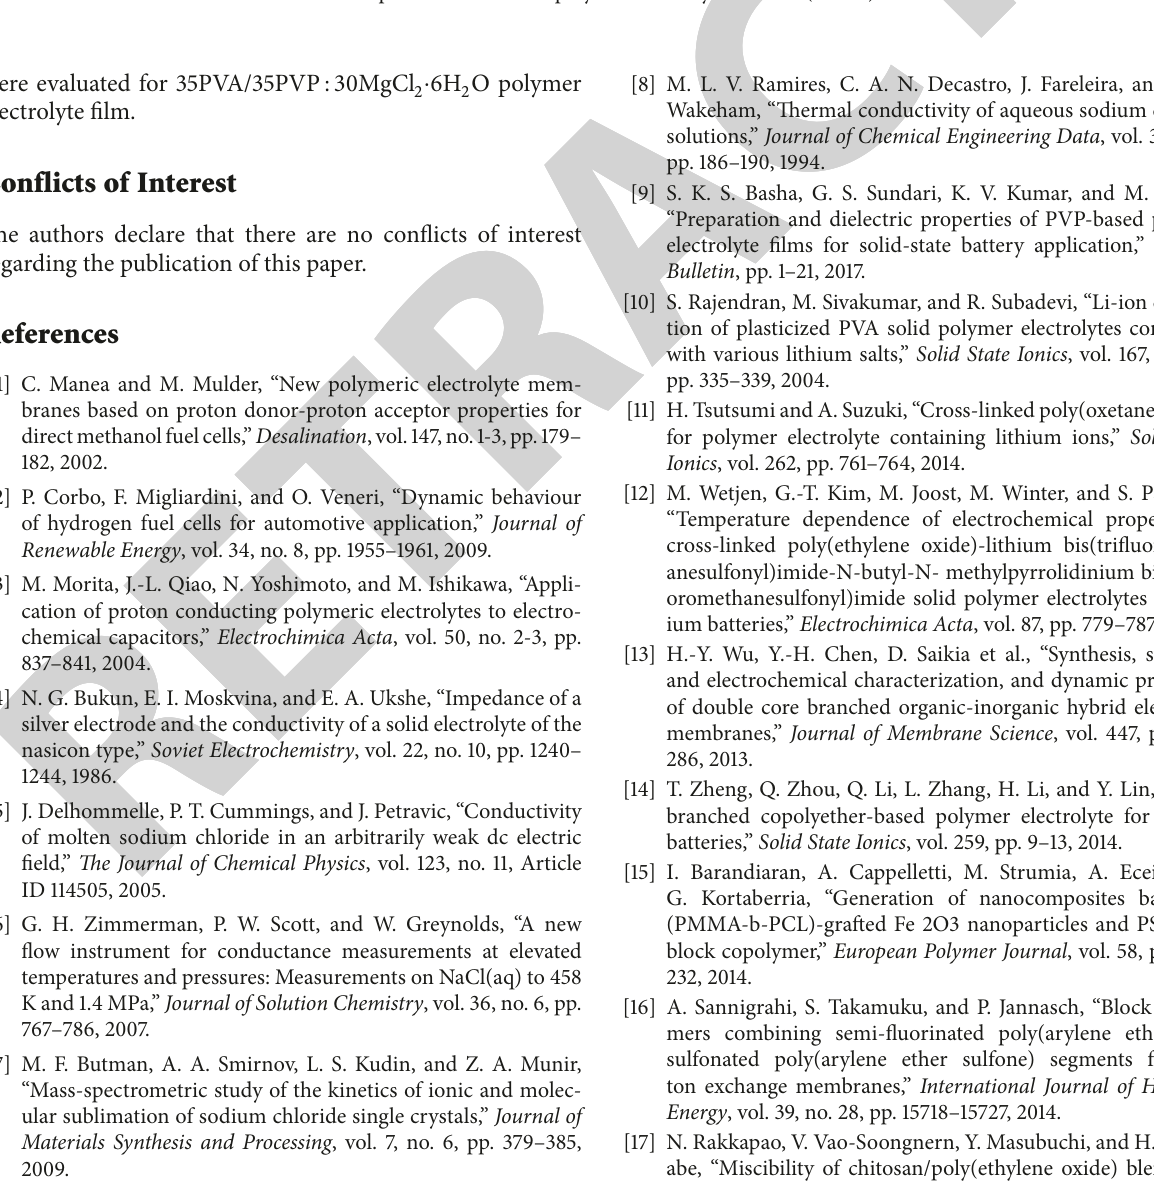
Figure 13: Cell parameters of solid polymer electrolyte film for (70 :30) wt% ratio.